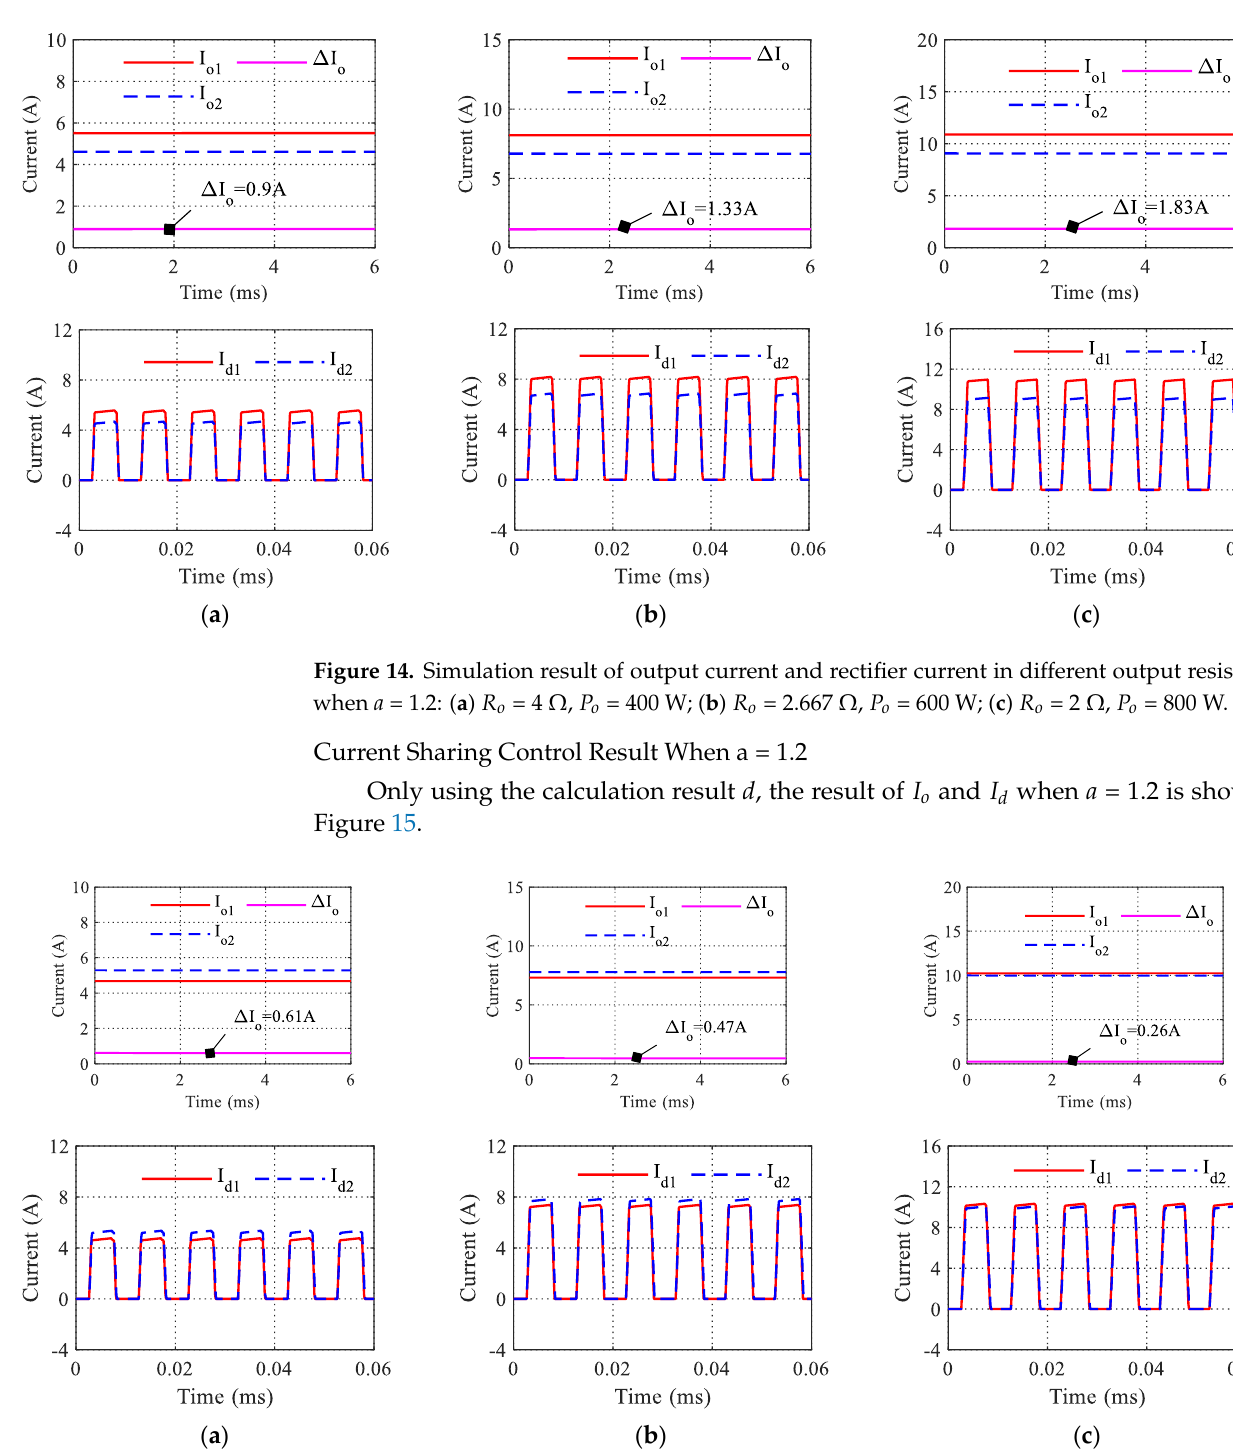
Figure 15. Simulation result of Figure 15. Simulation result of I o and I d in different P o after using calculation result when a = 1.2: ( a ) R o = 4 Ω , P o = 400 W; ( b ) R o = 2.667 Ω , P o = 600 W; ( c ) R o = 2 Ω , P o = 800